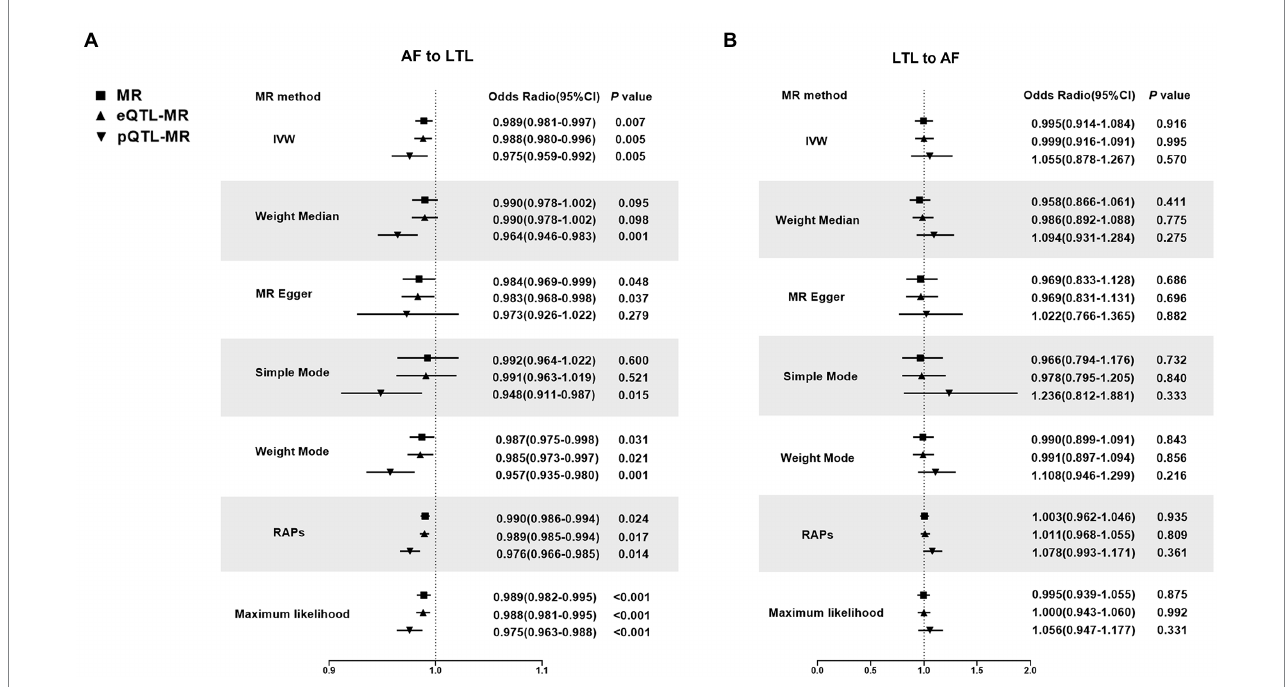
FIGURE 2 Mendelian Randomization estimators of the causal relationship between leucocyte telomere length and atrial fibrillation in original analyses. (A) AF-LTL. (B) LTL-AF. Analyses were conducted using the conventional IVW, Weighted median, MR Egger, Simple mode, Weighted mode, Robust adjusted profile score (RAPS) methods, Maximum likelihood. The slope of each line corresponds to the estimated MR effect per method. MR, Mendelian randomization; IVW, Inverse variance weighted; RAPS, robust adjusted profile score; LTL, leucocyte telomere length; AF, atrial fibrillation; eQTL, expression quantitative trait loci; pQTL, protein quantitative trait